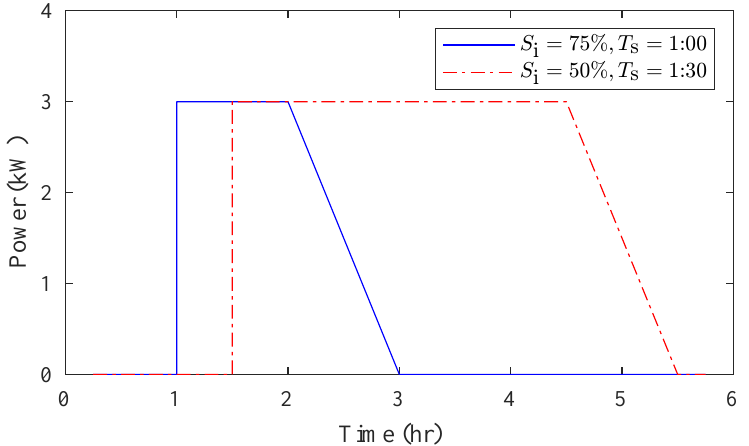
Figure 3. Examples of the charging profiles of EV batteries with different S i and T s